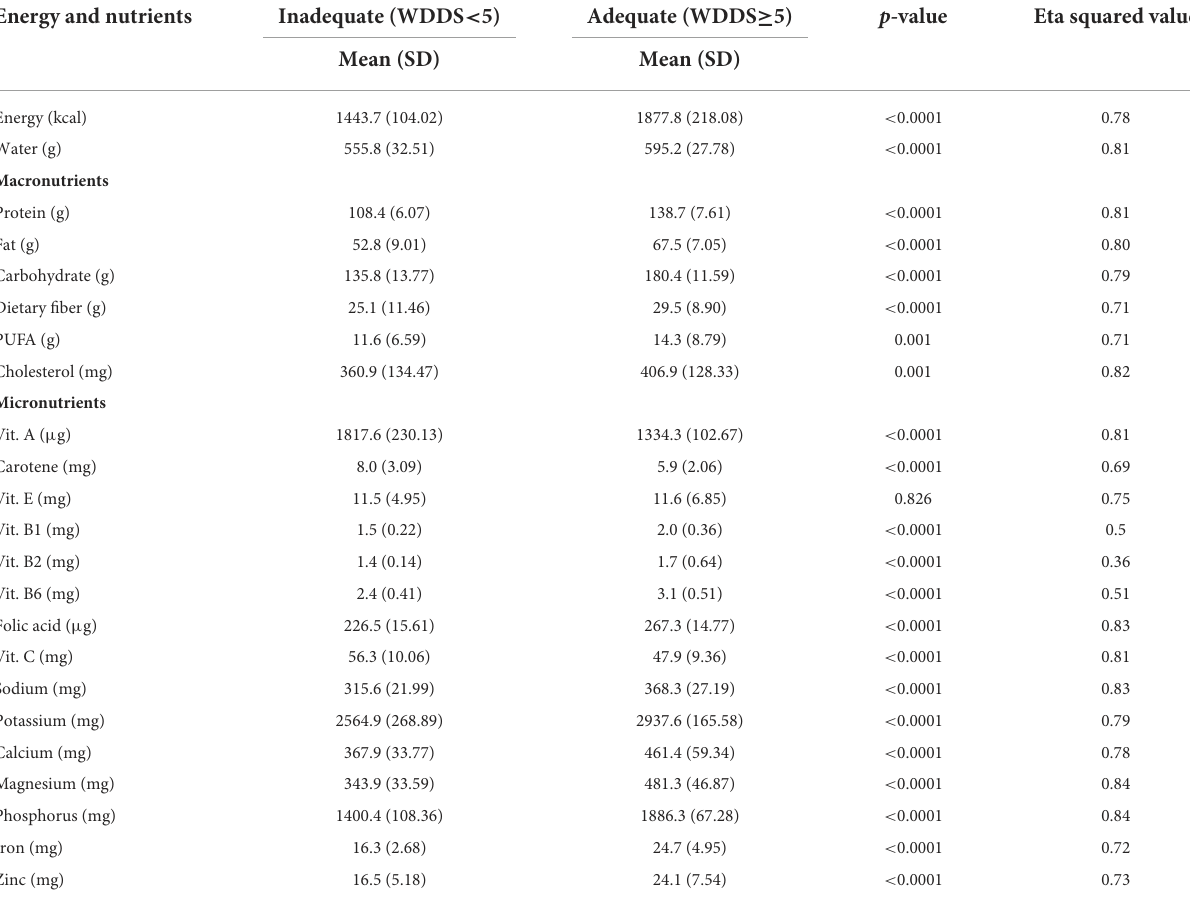
TABLE 3 Consumed energy, macronutrients, and micronutrients by diet diversity of study participants in the east Gojjam zone, northwest Ethiopia. 2019/2020. Energy and nutrients